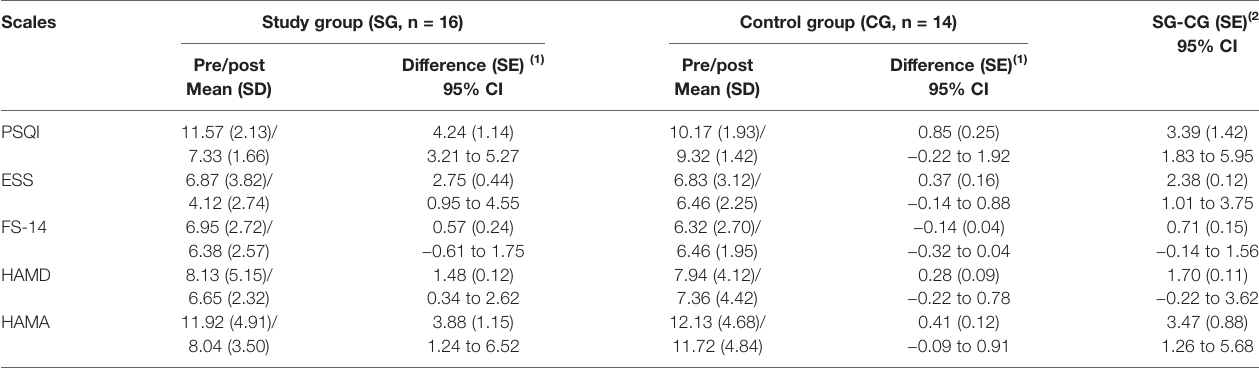
TABLE 4 | Comparison of scale measures between the two groups.